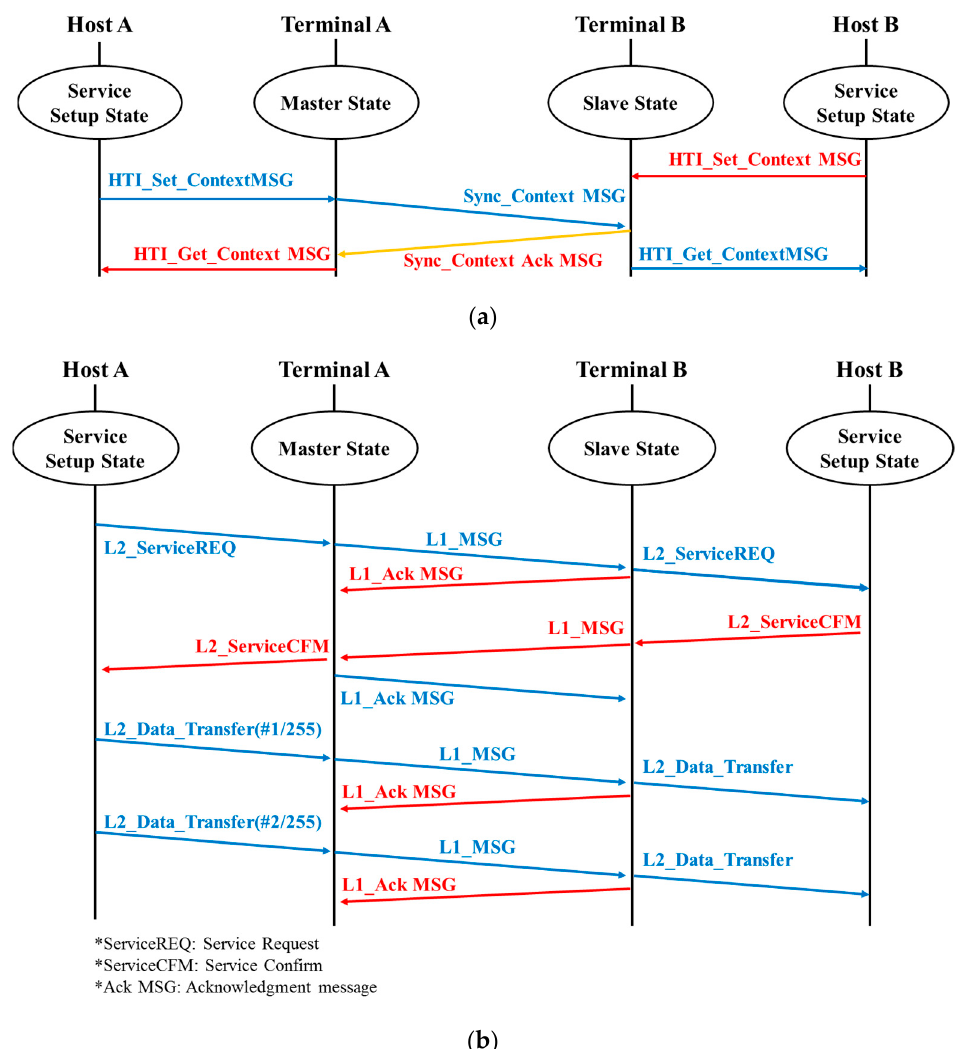
Figure 5. ( a ) Network setup ladder diagram and ( b ) Data transmission ladder diagram.